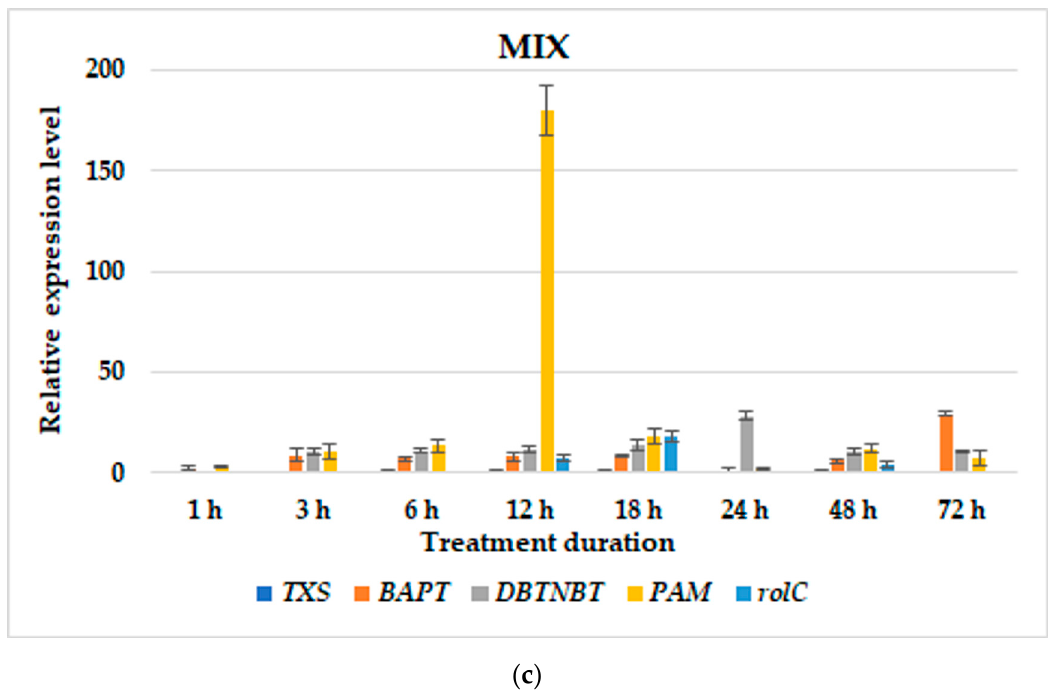
Figure 4. The effect of elicitation on relative gene expression profiles in hairy root cultures treated with ETOH ( a ), MeJA( b ) or MIX ( c ). Data represent mean values ± SD from three independent experiments.